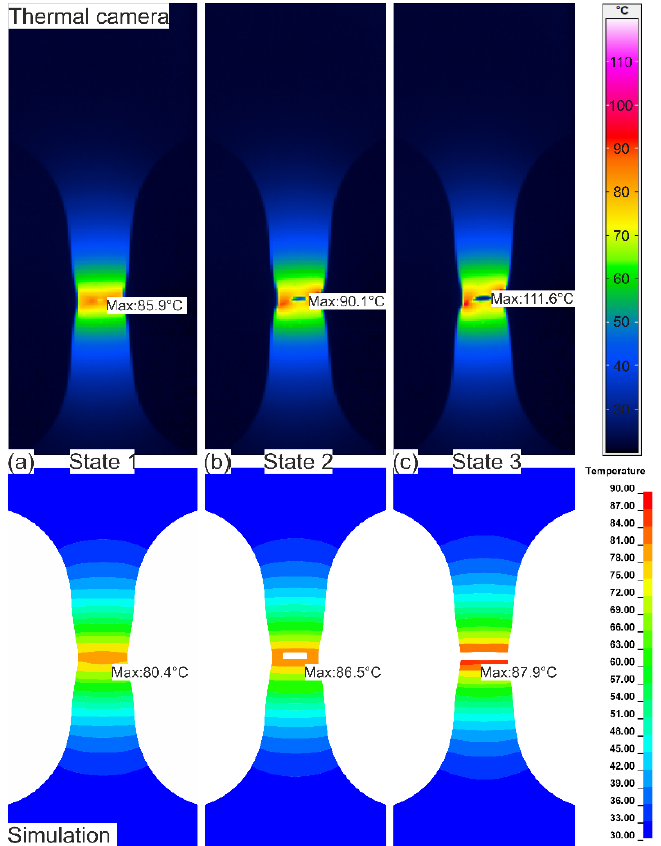
Figure 14. Comparison of the experimentally measured temperature value of the sample using the thermal camera with the simulation values for the strain rate of 0.1 for state 1: before failure ( a ), state 2: failure already initiated ( b ), and state 3: after failure ( c ).